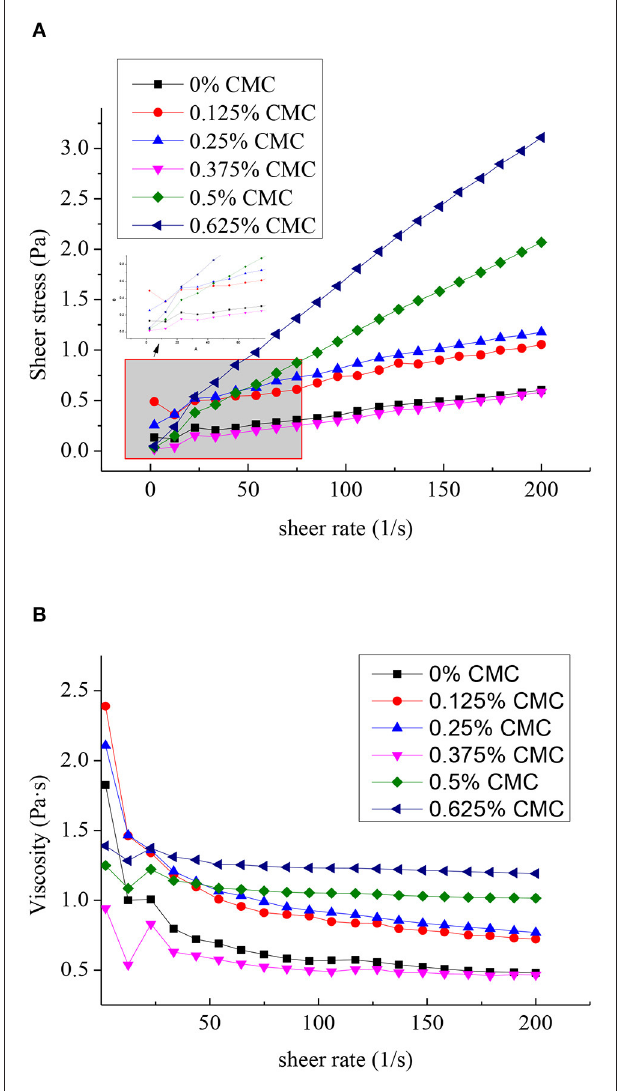
FIGURE 4 | Flow curves (A) and the apparent viscosity (B) of the SPI-stabilized rice bran oil emulsions with different concentrations of CMC (shear rate ranging from 2 to 200 s − 1 at pH 3.5, 25 ◦